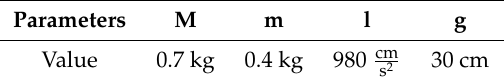
Table 1. Parameters of the system